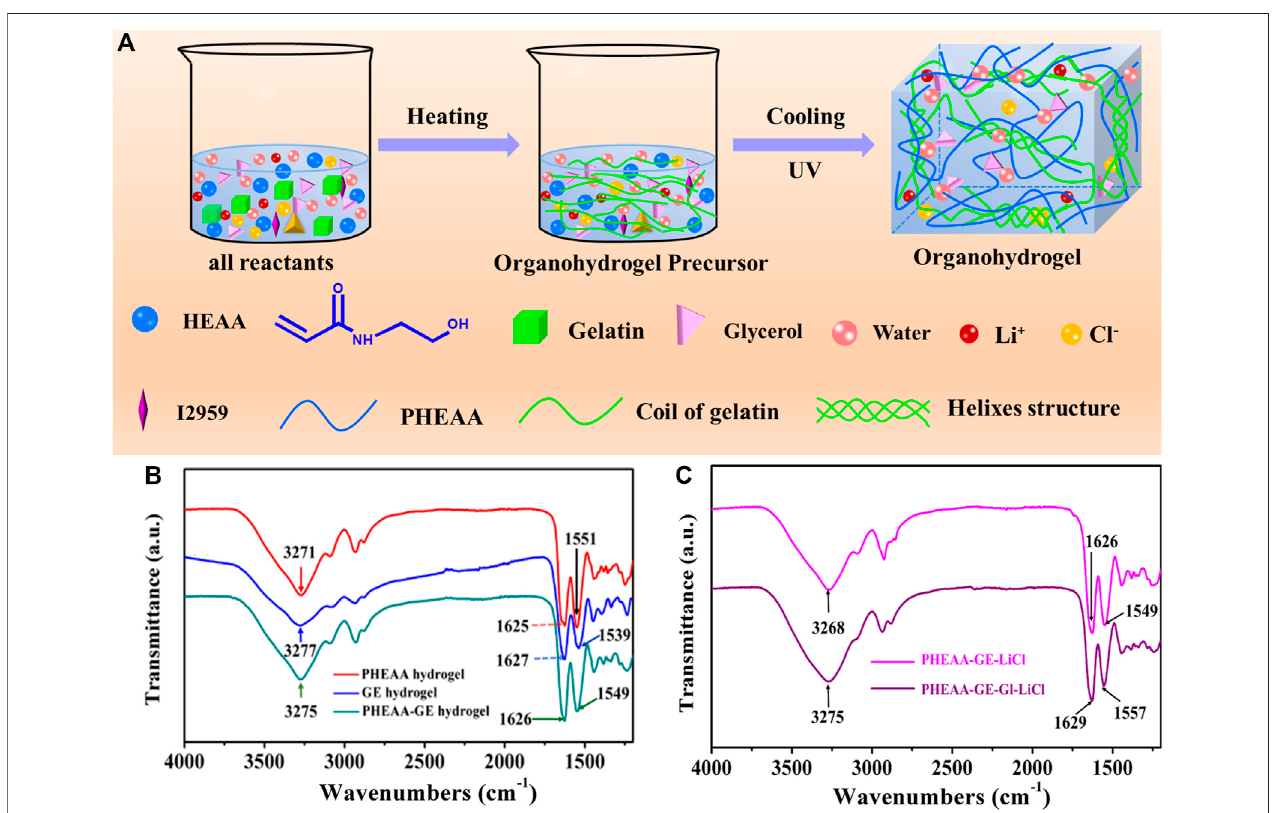
FIGURE 1 | (A) Schematic of a one-pot synthesis of a fully physically cross-linked PHEAA-GE-Gl-LiCl organohydrogel. (B) ATR-FTIR spectroscopy of PHEAA SN hydrogel, GE SN hydrogel, and PHEAA-GE DN hydrogel. (C) ATR-FTIR spectroscopy of PHEAA-GE-LiCl hydrogel and PHEAA-GE-Gl-LiCl organohydrogel.